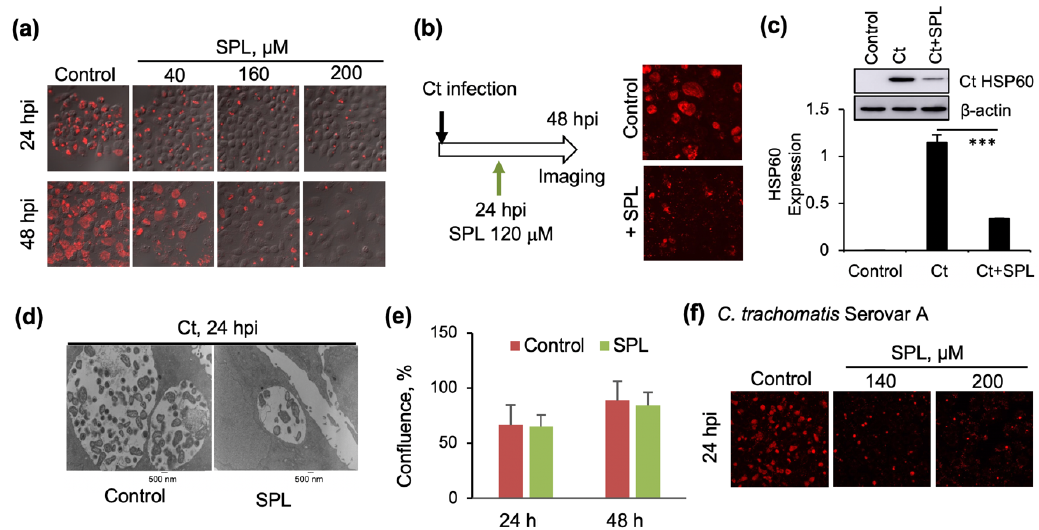
Figure 1. Inhibition of Ct infections by spilanthol (SPL): ( a ) Confocal microscopy imaging of cells infected with Chlamydia trachomatis (Ct) serovar D and SPL vehicle control (DMSO) at 24 h (upper) or 48 h post infection (hpi) (lower) or with SPL followed immediately by infection with Ct serovar D, and similarly imaged at 24 or 48 hpi. Chlamydial inclusions were visualized with anti-chlamydial major outer membrane protein (MOMP) antibody (red) and the image was overlayed with phase contrast image of cells. ( b ) Similar to panel ( a ) with the difference that SPL (120 µ M) was added at 24 hpi and then the cells were imaged after additional incubation for 24 h (48 hpi). ( c ) Quantification of the effects of SPL on Ct infection by Western blot analysis of chlamydial HSP60 protein (*** p < 0.001). Control represents cells treated with heat-inactivated Ct and 0.1% DMSO. ( d ) Transmission electron microscopy (TEM) imaging (9,300 × ) comparing Ct inclusions of SPL (120 µ M) treated and vehicle (DMSO) treated cells at 24 hpi. The small darker features within the inclusion are the elementary bodies (EBs) while the larger lighter gray features are the reticulate bodies (RBs). ( e ) The effects of SPL (120 µ M) on the proliferation of HeLa cells in the absence of Ct infection were quantified by analyzing the percent confluence over time using the IncuCyte ZOOM live-cell imager. The data at 24 and 48 h were extracted and plotted as bar graph. There was no statistically significant difference between control and SPL treatment conditions at either one of the timepoints. ( f ) As in panel ( a ), with the difference of infection being performed with Ct serovar A. All data representative of a minimum two biological